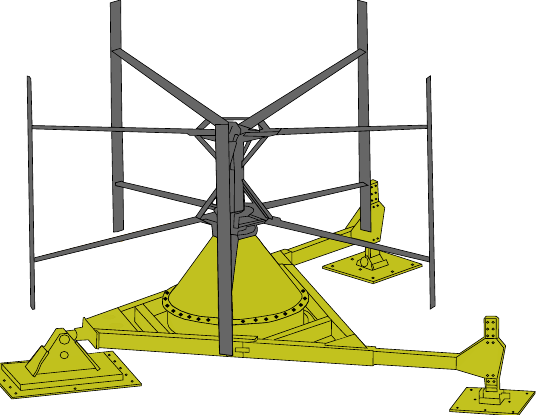
Figure 1. The Marine Current Energy converter rated at 7.5 kW, that can be placed on the river or sea bed. A five-bladed fixed pitch Vertical Axis Current Turbine is connected directly (no gearbox) to a Permanent Magnet Synchronous Generator. The radius, r , is 3 m and the height is 3.5 m to give a projected cross sectional area of 21 m 2